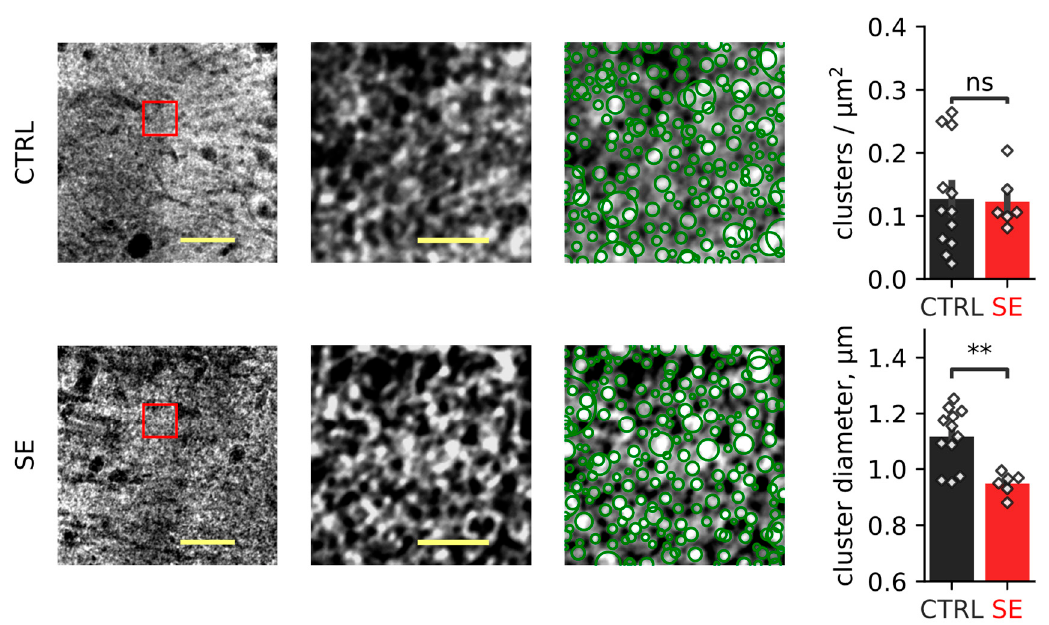
Figure 9. EAAT2 immunostaining. Representative examples of EAAT2 immunostaining from the dorsal hippocampus of control (CTRL) and experimental (SE) groups. Left: maximal projection of EAAT2-stained stack. Scale bar = 25 µ m. Middle: Expanded part of the image boxed in the left image. The expansion shows the structural organization of EAAT2, which forms clusters. Scale bar = 5 µ m. Right: detection of EAAT2 clusters. Bar graphs show relative EAAT2 cluster density and the mean cluster diameter. Data presented as mean ± SEM. Each rhombus represents a value obtained in an individual animal. t -test, ** p <